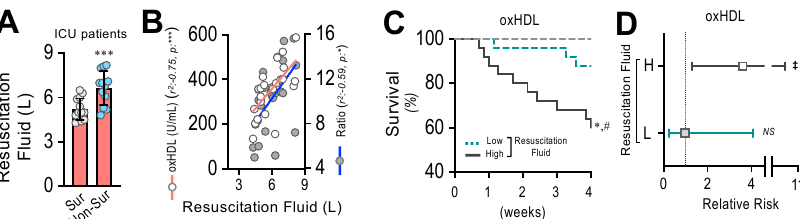
Figure 9. Resuscitation fluid dose administered to ICU patients correlates with plasma oxHDL and oxHDL/HDL ratio levels, which is associated with decreased survival and increased risk of death. ( A ). Resuscitation fluid volume administrated to surviving and non-surviving ICU patients. ( B ) Correlation analyses between resuscitation fluid volume and oxHDL and oxHDL/HDL ratio determinations in ICU patients. ( C , D ). Survival (Kaplan–Meier) curves comparing high and low resuscitation fluid volume of ICU patients. *, p = 0.001 (log-rank (Mantel–Cox) test) when comparing high versus low resuscitation fluid volume of ICU patients. #, p = 0.007 (Gehan–Breslow–Wilcoxon test) when comparing high versus low resuscitation fluid volume of ICU patients. (N = 16) ( C ). Contingency analyses performed to determine relative risk between high and low resuscitation fluid volume of ICU patients. ‡, p = 0.007 (Fisher’s exact test) compared to HVs (N = 16) ( D ). Statistical differences were assessed by Student’s t -test (Mann–Whitney). *** p < 0.001. Results are expressed as the mean ±